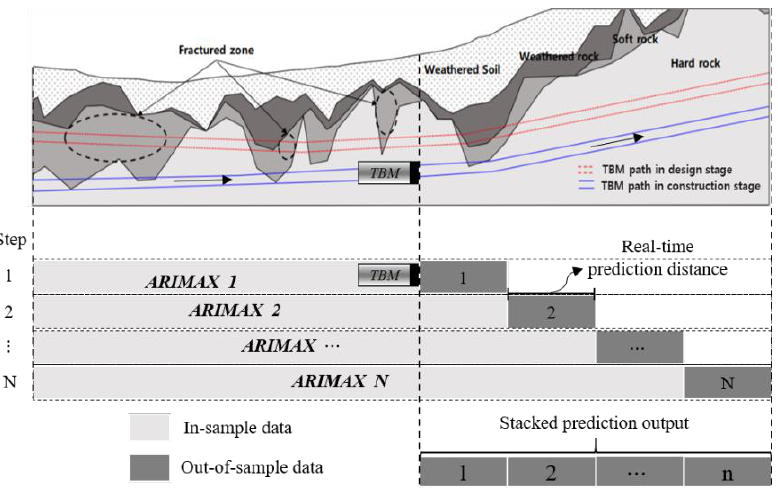
Figure 1. Example of real-time prediction procedure for walk forward (WF) in project A-1.